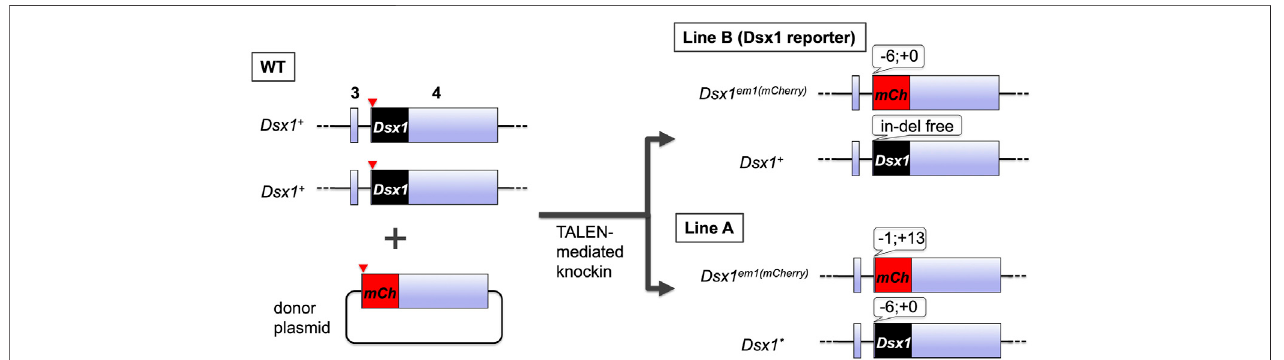
FIGURE 5 | Generation and genotypes of the transgenic D. magna harboring the mCherry coding sequence at the Dsx1 locus. The TALANs induced a double-strand break at the start codon of Dsx1 ORF on exon 4. Concomitantly, it also cleaved near the start codon of mCherry ORF fused with Dsx1 3 ′ UTR on the donor plasmid, resulting in the generation of two transgenic lines, Line A and Line B.